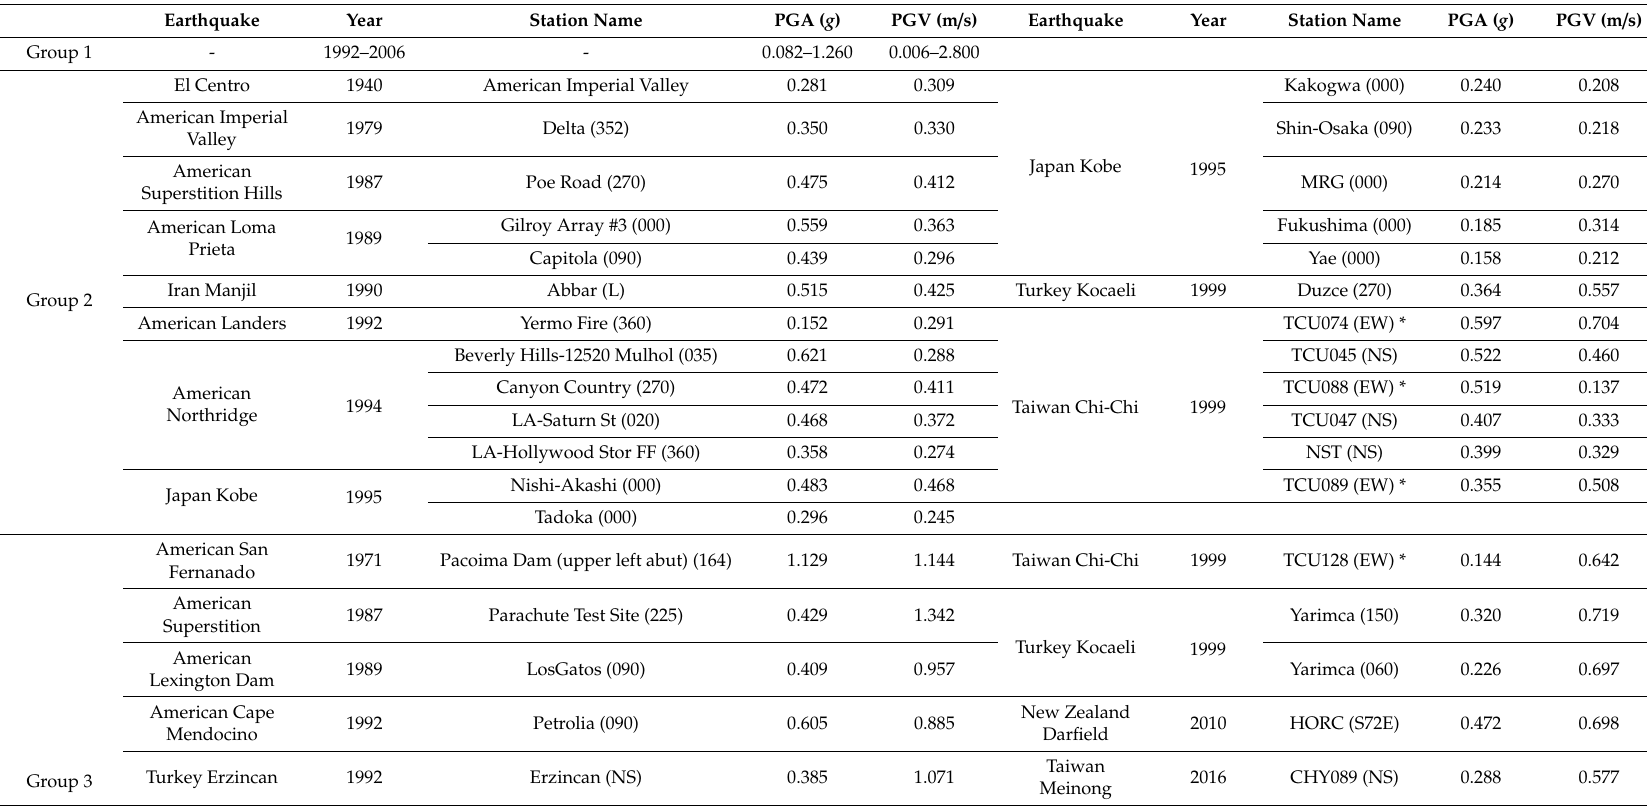
Table 1. Ground motions considered for horizontal acceleration inputs (* denotes the ground motions duplicated in Groups 1 and 2 (or 3)).